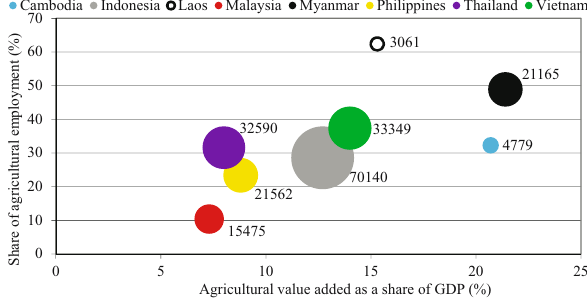
Figure 1: Basic agricultural indicators of the ASEAN, 2019. 1 Author ’